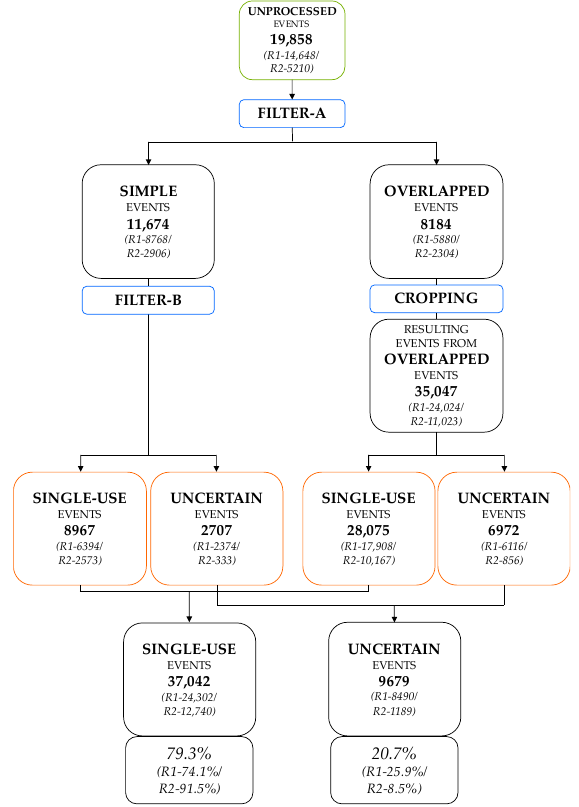
Figure 8. Classification of events after filtering and cropping (disaggregation process).